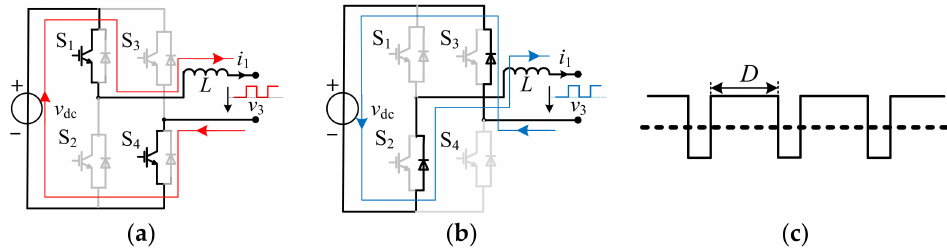
Figure 6. CCD-PVC state analysis: ( a ) current path when S 1 and S 4 are both on; ( b ) current path when S 1 and S 4 are both off; and ( c ) output voltage.